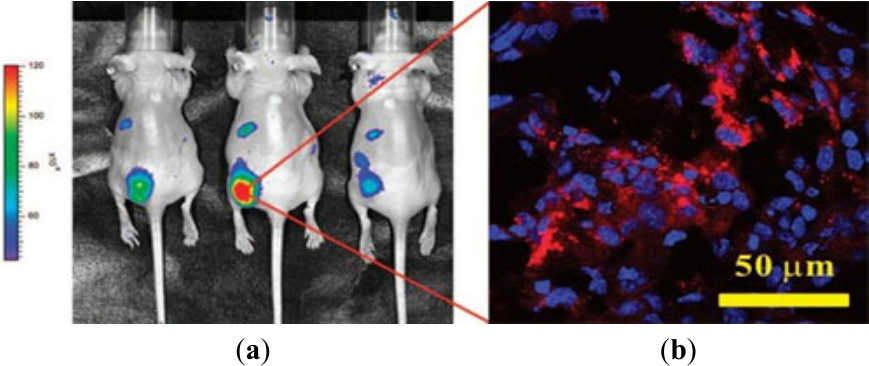
Figure 3. ( a ) Left panel: In vivo fl uorescence imaging of three nude mice bearing MCF-7/HER2 xenografts implanted in the lower back 30 h after i.v. injection with anti- HER2 QD-ILs; ( b ) Right panel: A 5 µm section cut from frozen tumor tissues